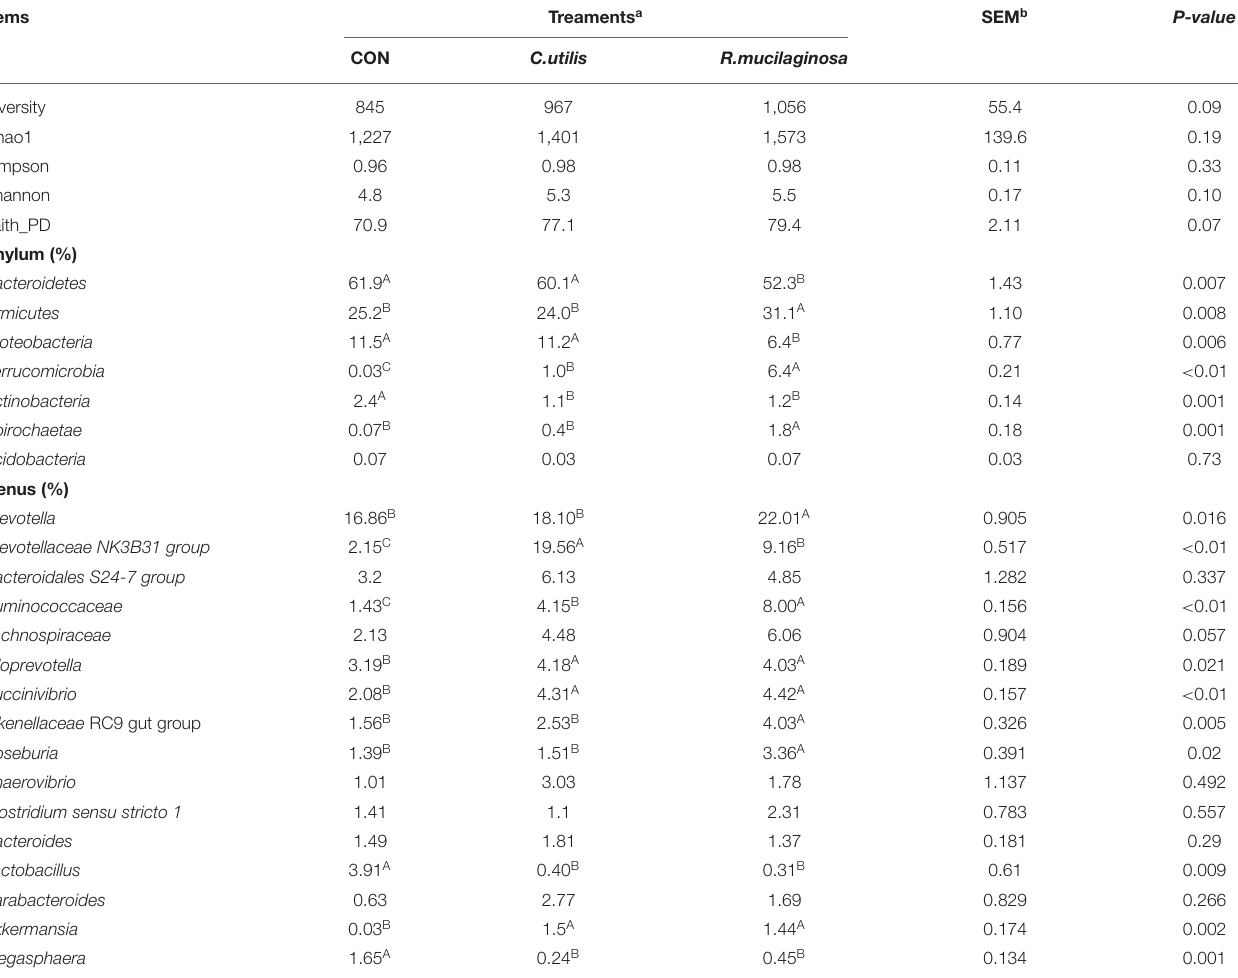
TABLE 9 | Effects of C. utilis DSM 2361 and R. mucilaginosa TZR 2014 on alpha diversity and of phylum and genus level microbial composition in cecum of weaned piglets ( n =